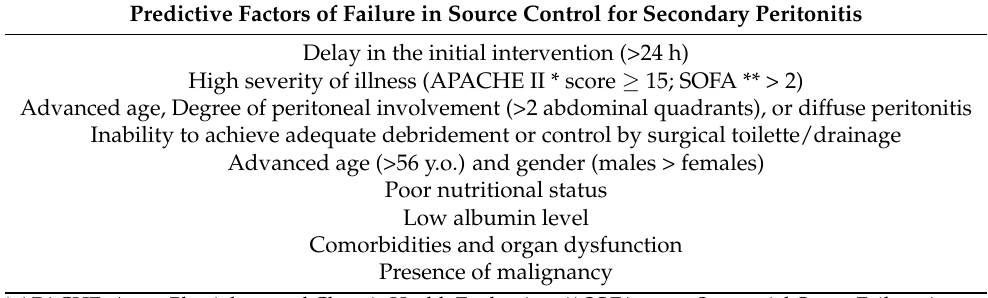
Table 1. Predictive factors of failure in source control for secondary peritonitis. Predictive Factors of Failure in Source Control for Secondary Peritonitis Delay in the initial intervention (>24 h) High severity of illness (APACHE II * score ≥ 15; SOFA ** > 2) Advanced age, Degree of peritoneal involvement (>2 abdominal quadrants), or diffuse peritonitis Inability to achieve adequate debridement or control by surgical toilette/drainage Advanced age (>56 y.o.) and gender (males >